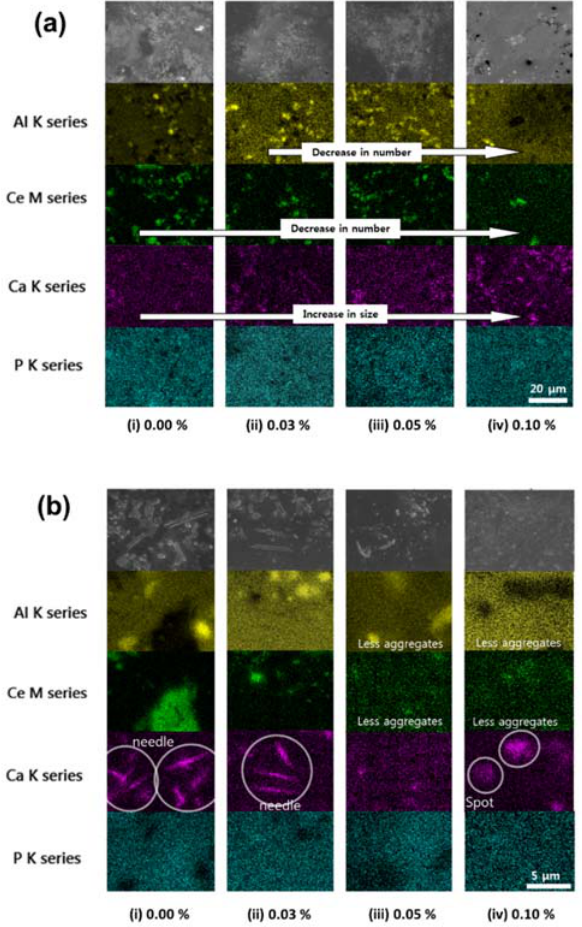
Figure 4. FESEM images and corresponding EDS analysis (Al, Ce, Ca, and P) for enamel-coated surface with the addition of SiC at ( a ) low and ( b ) high magnification.